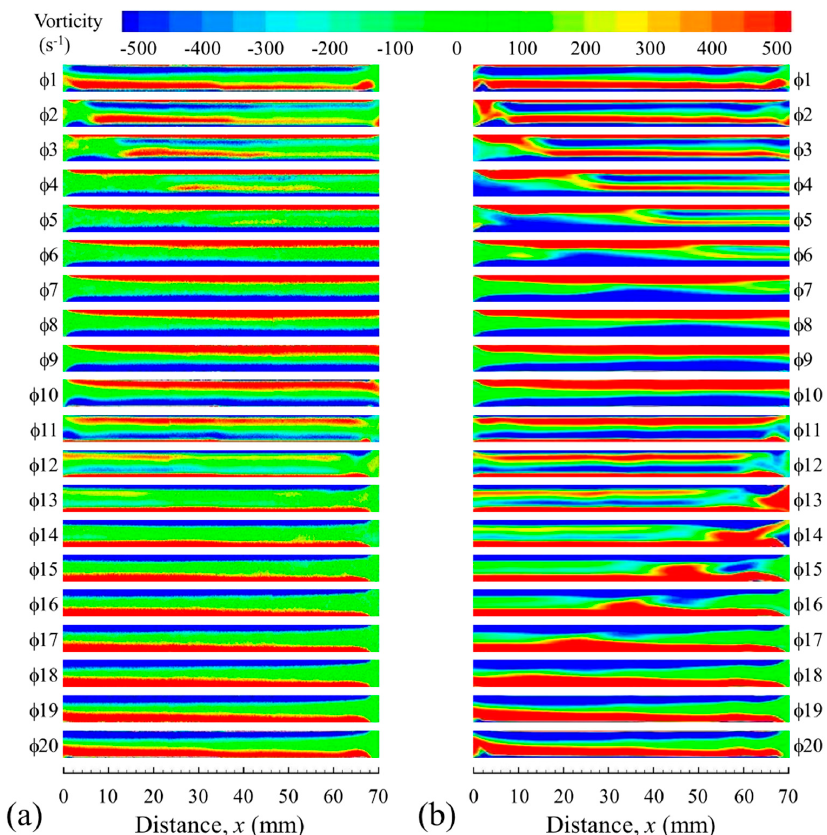
Figure 5. Comparison between vorticity contour from ( a ) experiment and ( b ) CFD laminar model. The drive ratio is 0.83%. Distance x is measured from the left end of HHX/CHX assembly; vertical axis, (cid:1877) , is omitted for simplicity; the ratio of (cid:1876):(cid:1877) is